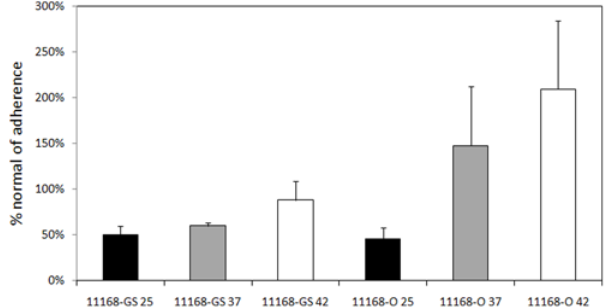
Figure 7. Relative adherence of C. jejuni 11168 to sialidase treated Caco-2 cells. Relative adherence of 11168-GS (left) and 11168-O (right) to sialidase treated Caco-2 cells with respect to normal adherence levels (25 u C, black bar; 37 u C, grey bar; and 42 u C, white bar).